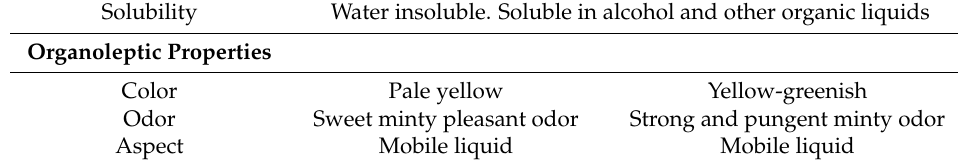
Figure 2. Yield profiles as a function of time for the SFME ( ) and HD ( Figure 2. Yield pro fi les as a function of time for the SFME ( ● ) and HD ( ○ ) extraction of EO from sweet basil leaves. basil leaves.